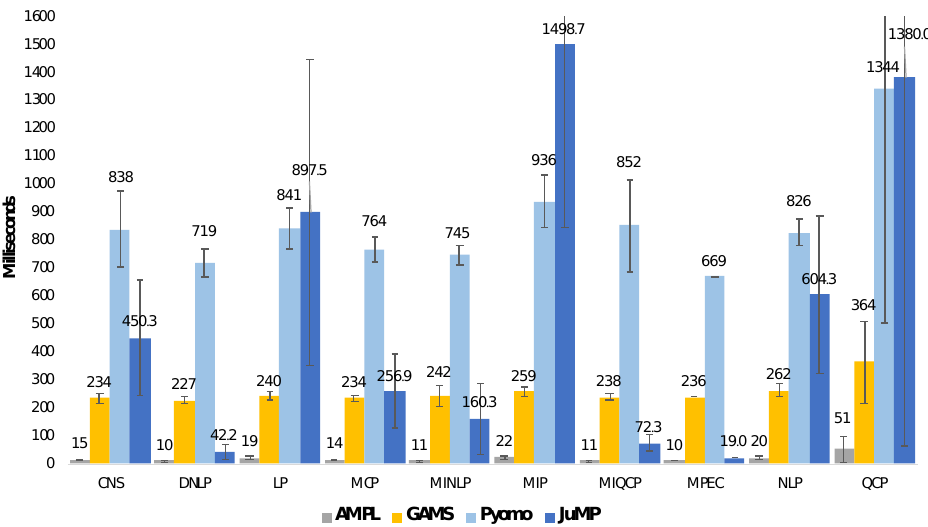
Figure 1. Average model instance creation time (in milliseconds) grouped by mathematical opti- mization problem type. Benchmark conducted by Jusevicius et al. [23] using models available in the GAMS library. It measures the time taken to load model instance and export to a format supported by the